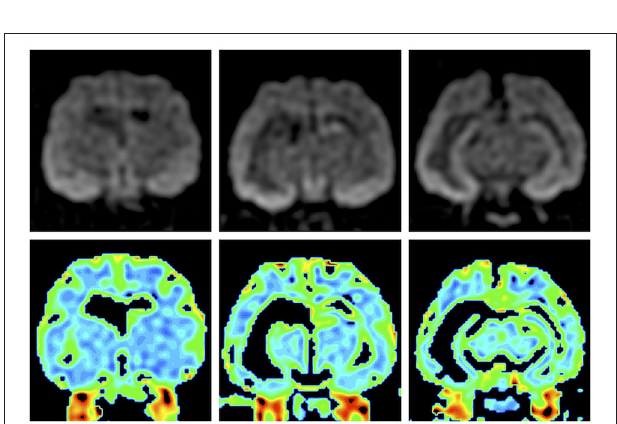
FIGURE 4 | Preoperative isotropic diffusion-weighted imaging (upper row) and colored apparent diffusion coefficient maps (lower row). Bilateral hippocampi and the right amygdala and temporo-occipital cortex showed hyperintensity, but there were no significant changes on the apparent diffusion coefficient